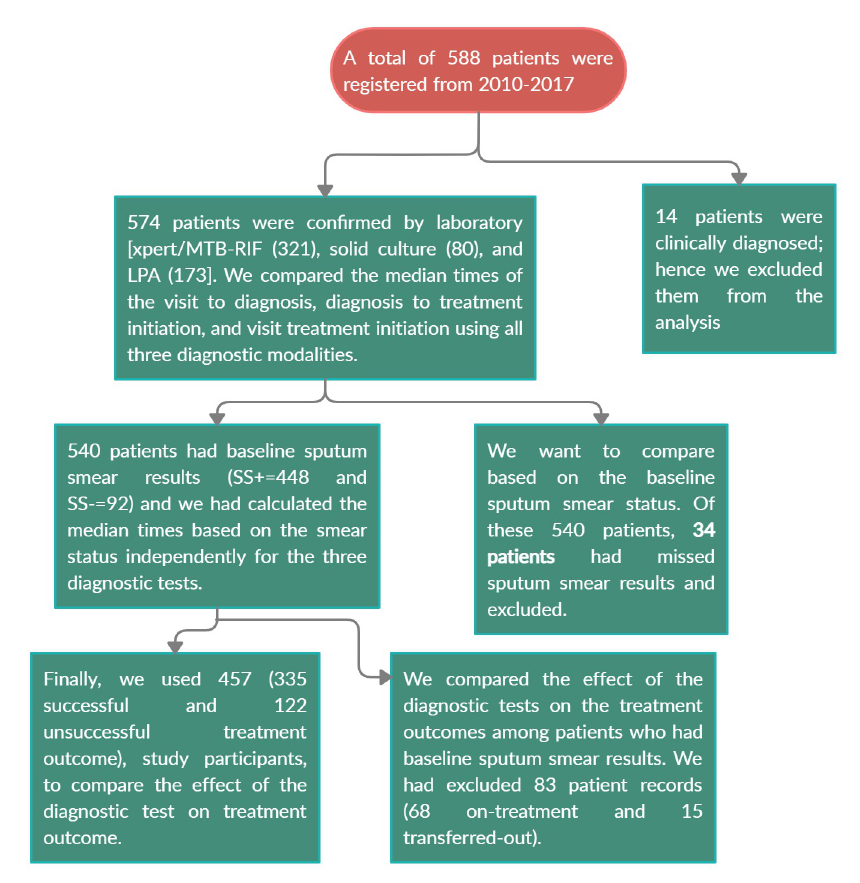
Fig 2. A diagram depicting the inclusion/exclusion of DR-TB patients to the